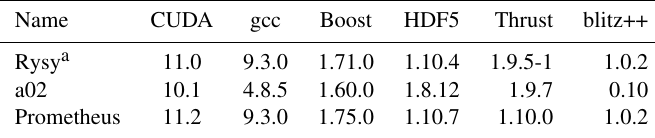
Table 2. List of software on the systems used.